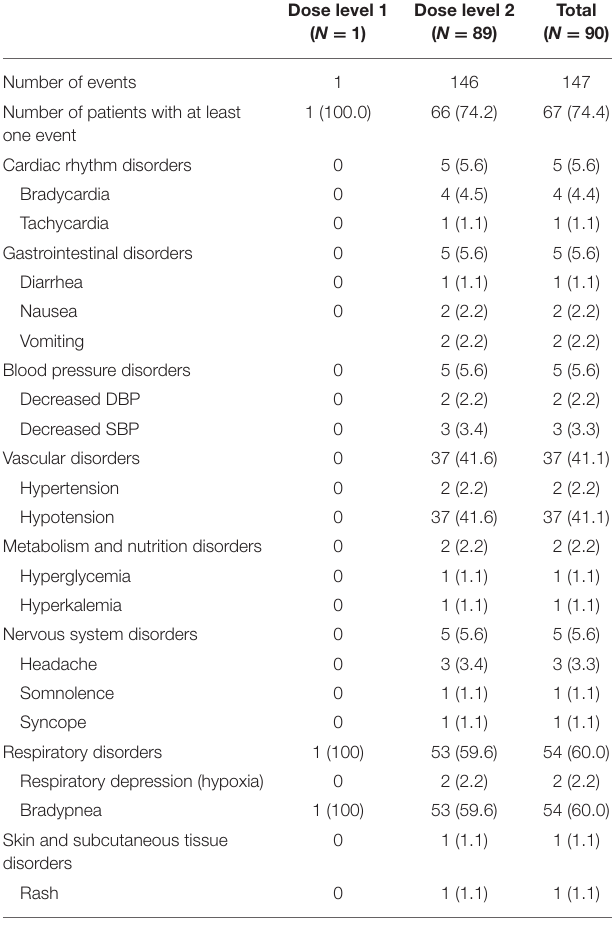
TABLE 3 | Demographic and baseline characteristics (safety evaluable population).